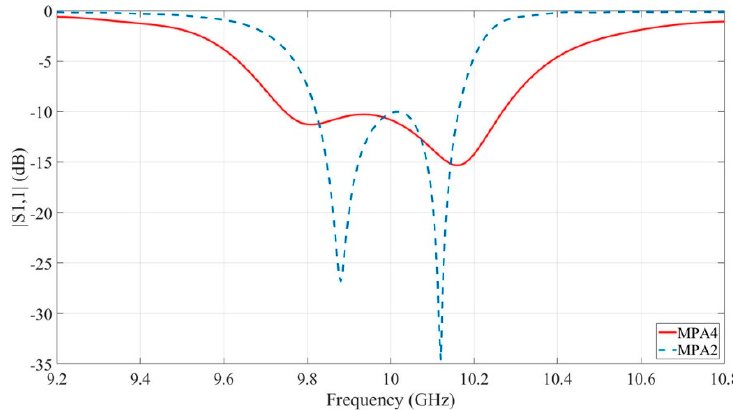
Figure 11. Simulated reflection coefficient for MPA2 and MPA4.